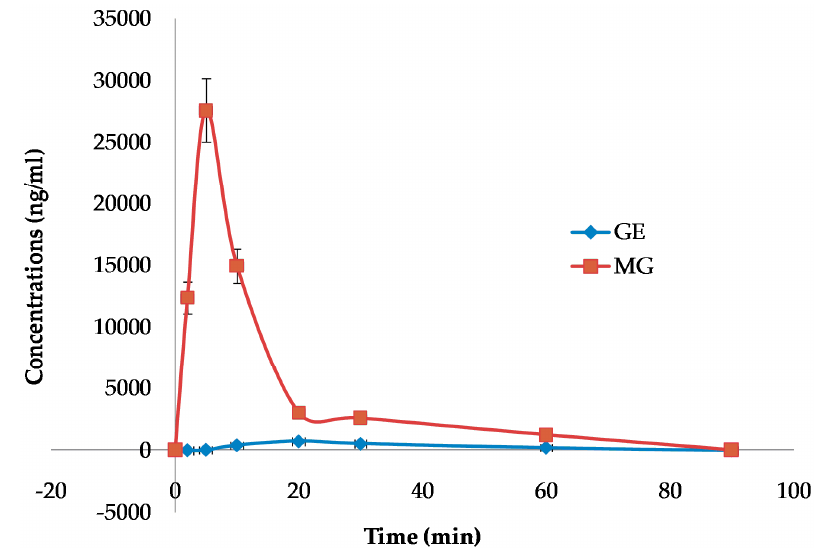
Figure 8. Mean brain drug concentration–time curve of mice after oral administration with GE or MG. Table 3. Main brain pharmacokinetic parameters of GE and MG in mice after oral administration. AUC 0–90 : Area under the curve; MRT last : mean residence time.